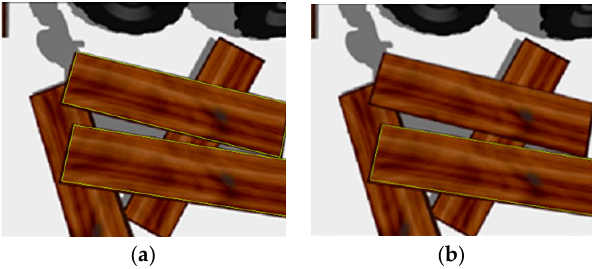
Figure 19. Wood plank recognition results: ( a ) Recognition results of some wood planks in the same cluster; ( b ) The board to be grasped.